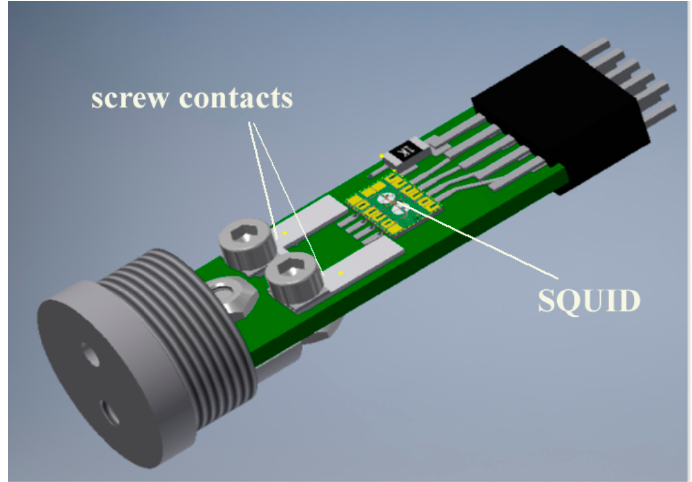
Figure 2. Schematic representation of Nb-based low-T c DC SQUID sensor developed at IRE. The cylindrical superconducting (Nb) shield has been removed for clarity.